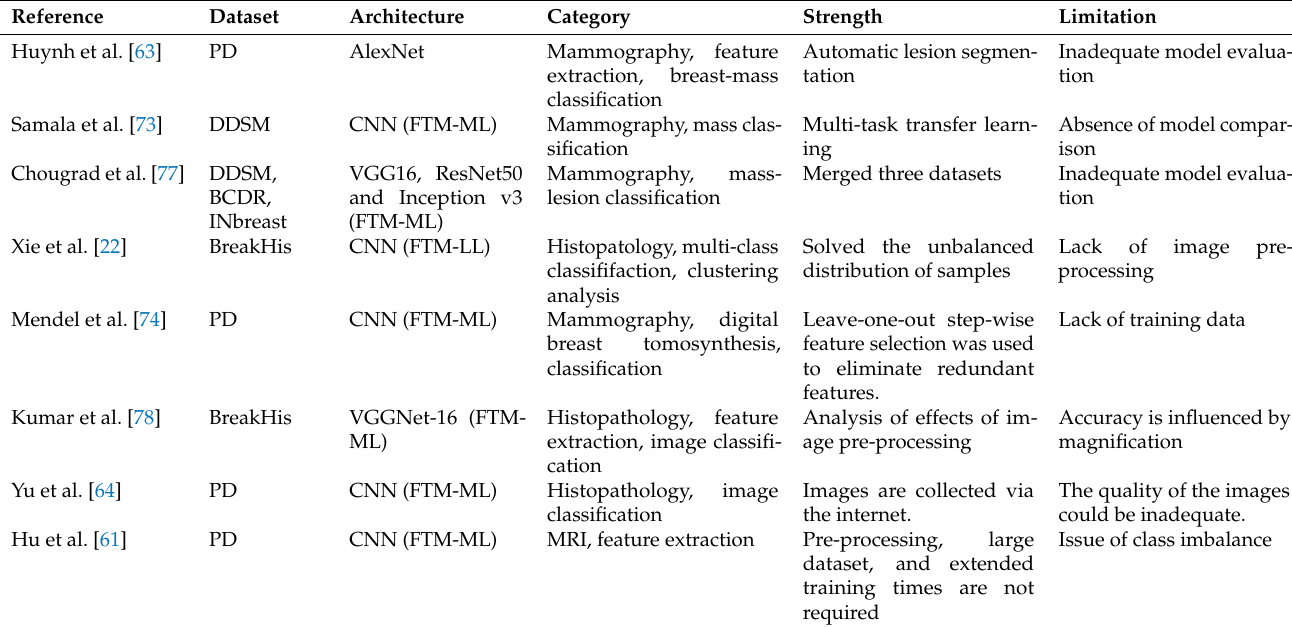
Table 6. State-of-the-art studies based on a TL-based